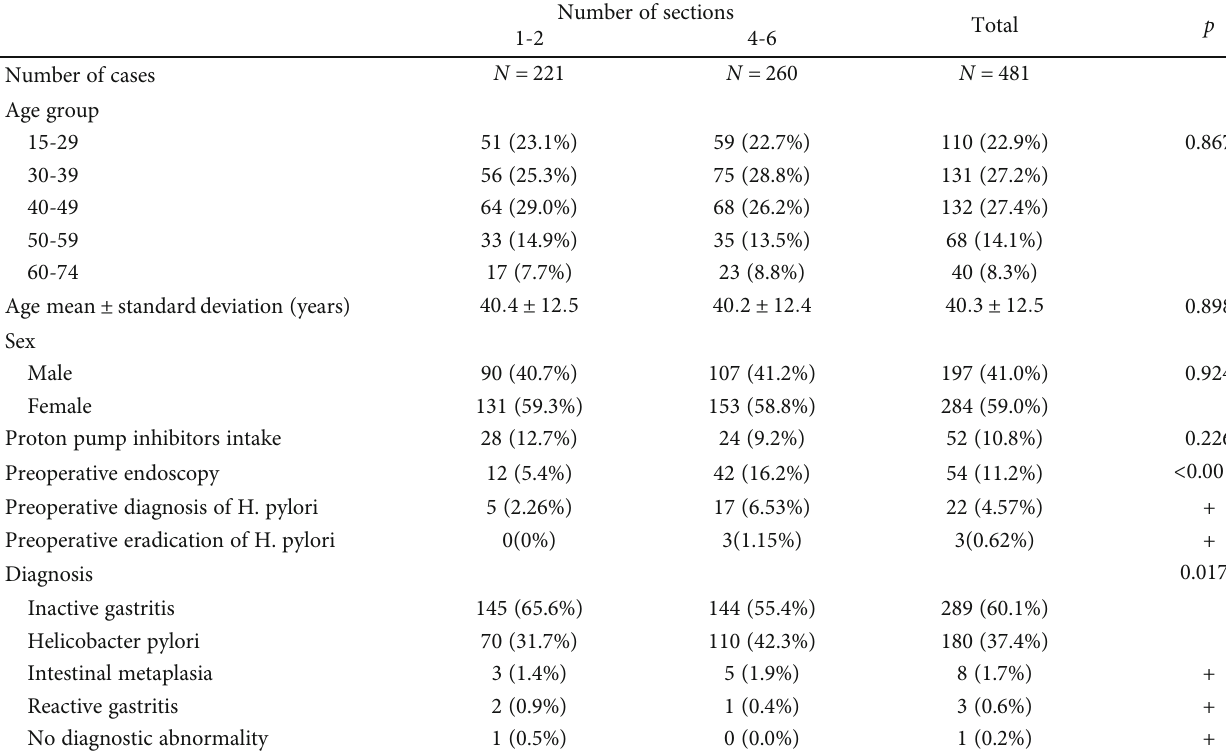
Table 1: Patients characteristics by number of sections